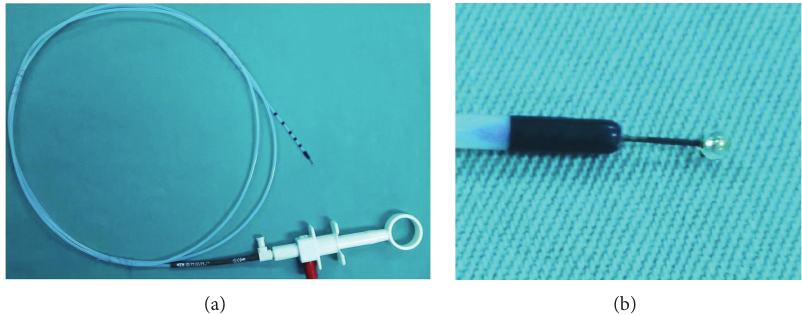
Figure 1: (a) The round insulated tip papillotome used in the study. (b) Note the small porcelain tip in the